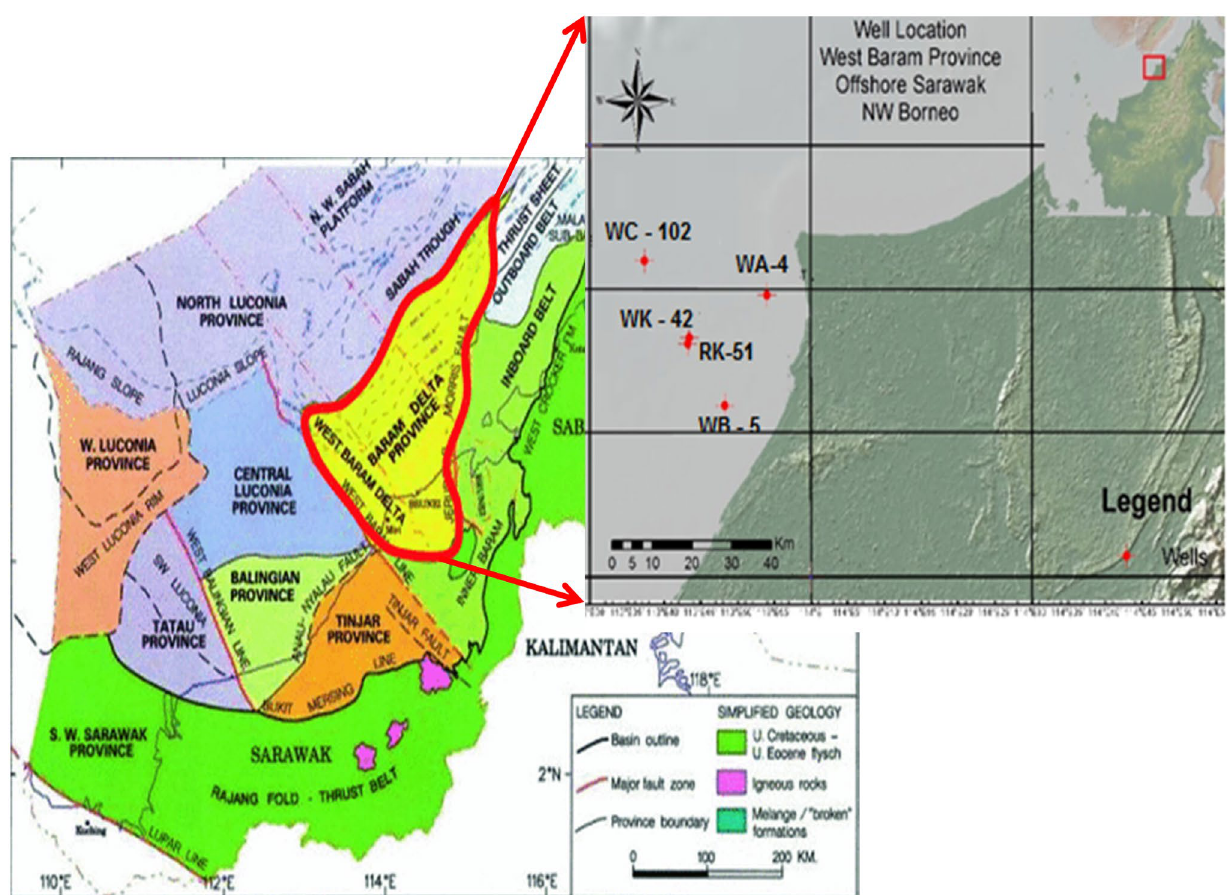
Fig. 1 Regional geology and well location map, modified after Madon